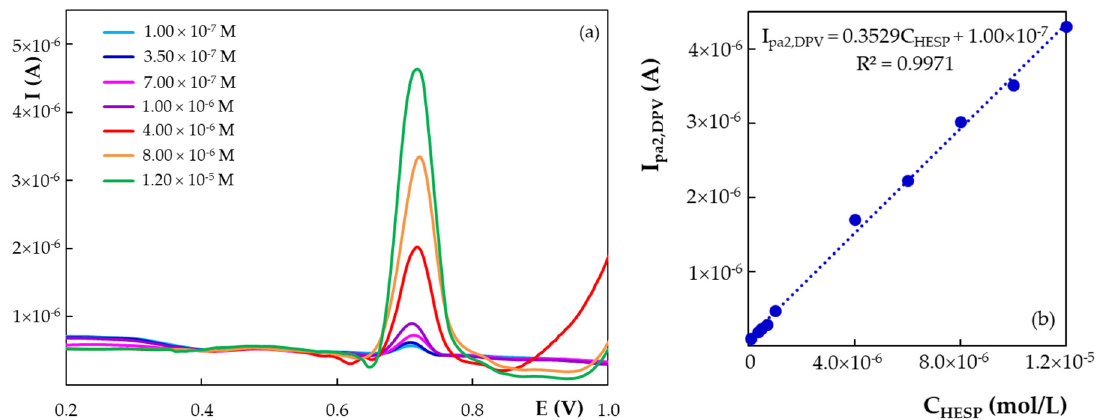
Figure 7. Selected differential pulse voltammograms recorded in the anodic direction at H type PGE for different concen- trations of HESP in BRB solution pH 1.81 and the corresponding calibration graph (inset). ( a ) Selected differential pulse voltammograms recorded ( b ) the corresponding calibration graph. Table 3. The performance characteristics of voltammetric methods reported in the literature for hesperidin determination. Technique